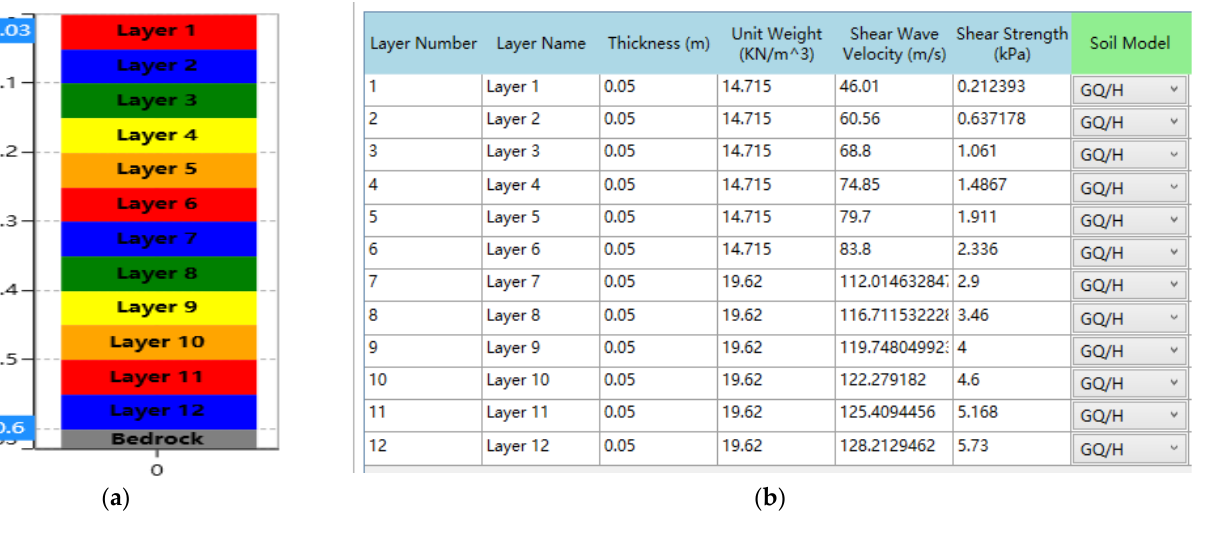
Figure 12. DEEPSOIL software: ( a ) Modeling in DEEPSOIL; ( b ) parameters of each layer. In 1972, Hardin and Drnevich [19] proposed a hyperbolic shear modulus reduction function and an approximate shape for the material damping curve for soil. Based on Hardin-Drnevich model, Darendeli [20] proposed a modified hyperbolic model as Equation (4). The curvature coefficient a is integrated into the normalized modulus reduction curve.